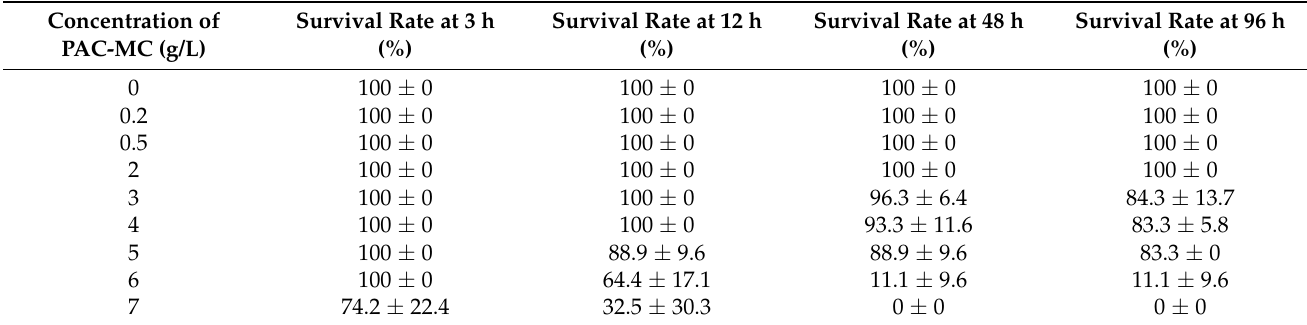
Table 1. Effect of PAC-MC on the survival rate of marine medaka larvae.